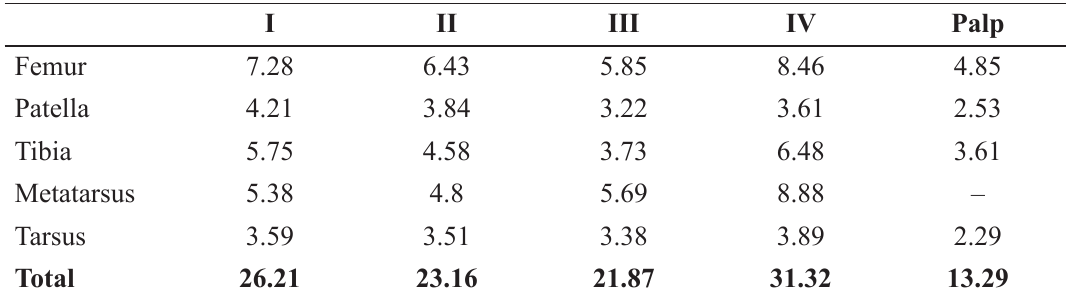
Table 4. Length of legs and palpal segments of holotype, ♂ (IBSP 168510) of Schismatothele moonenorum sp.